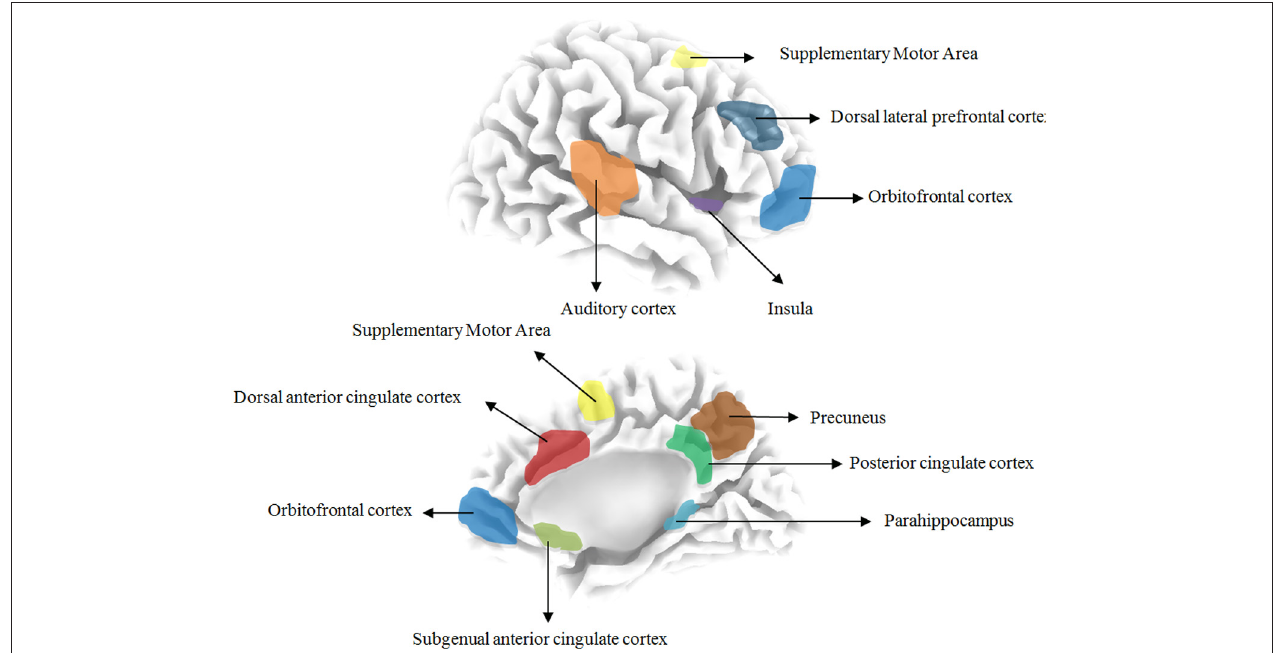
FIGURE 1 | Overview the different brain areas based on resting state EEG in tinnitus